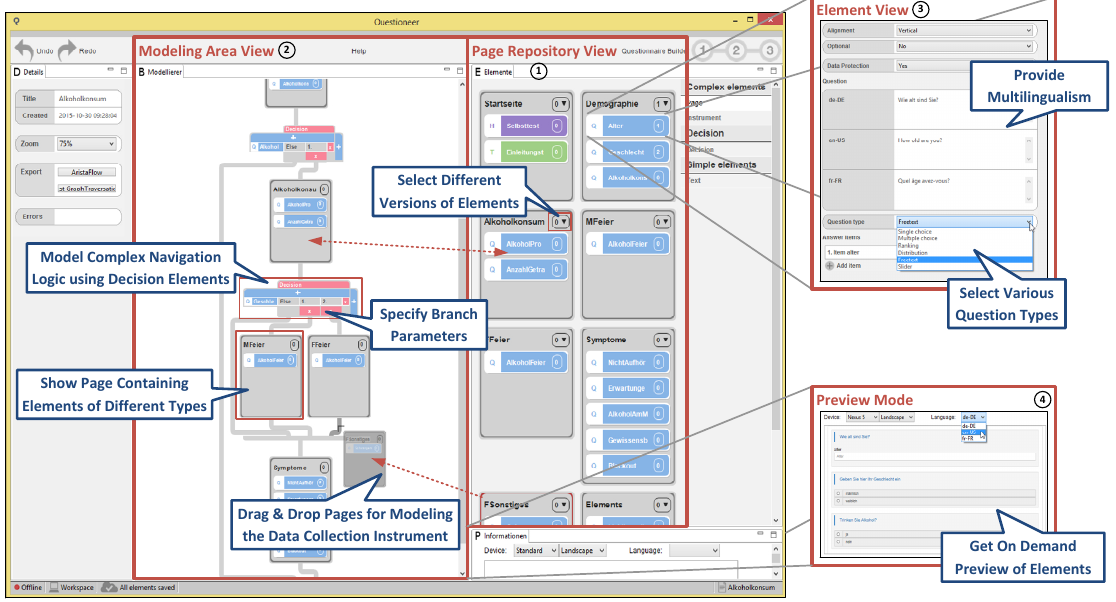
Figure 3. The QuestionSys